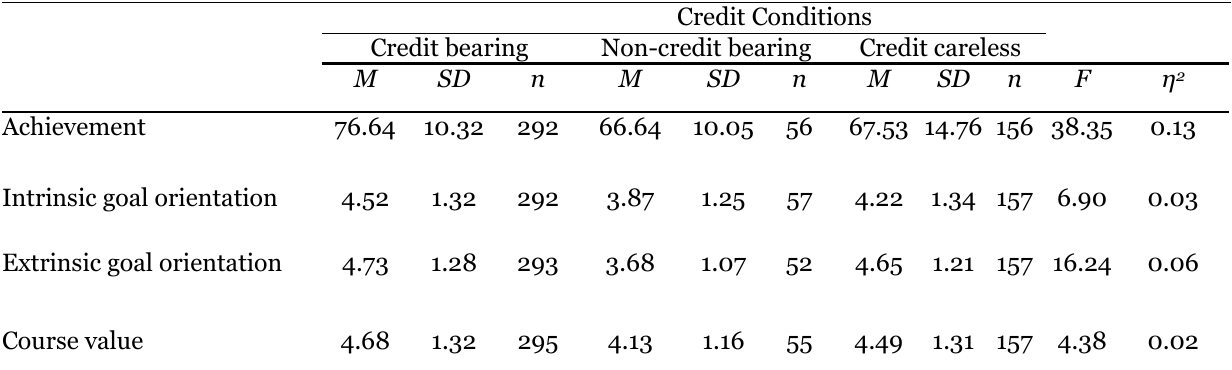
Summary of One-Way ANOVA Results for Three Credit